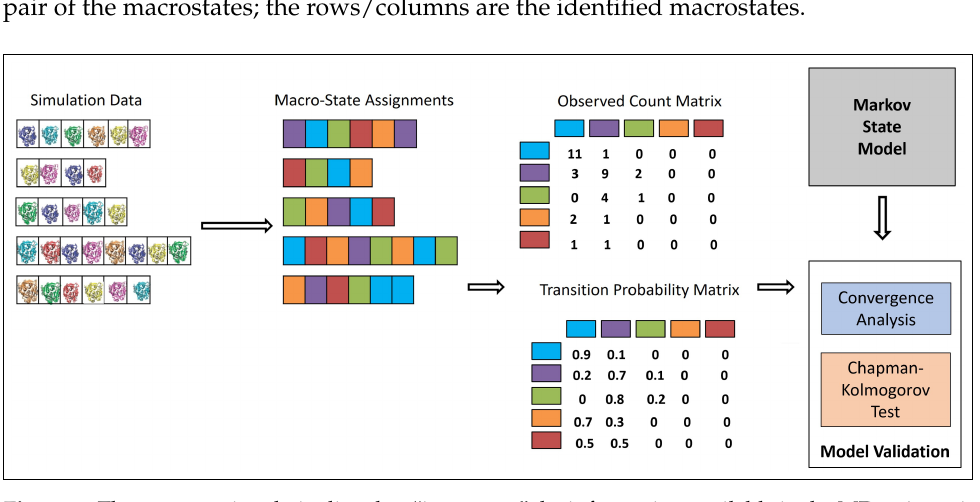
Figure 1. The computational pipeline that “integrates” the information available in the MD trajectories into an MSM of the system’s dynamics. The different color codes are representing the different macro- states/groups; we also color-code the structures to illustrate their assignments to specific